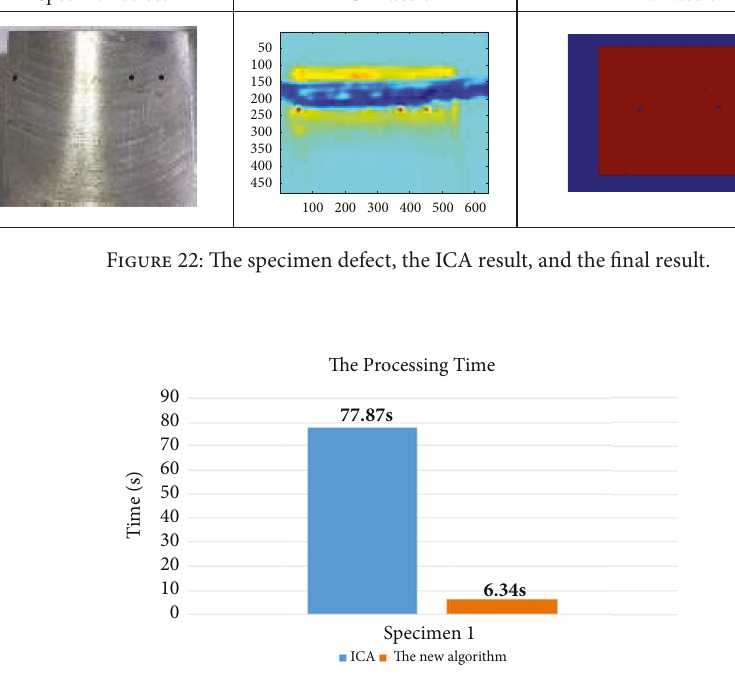
Figure 23: The time comparison for specimen